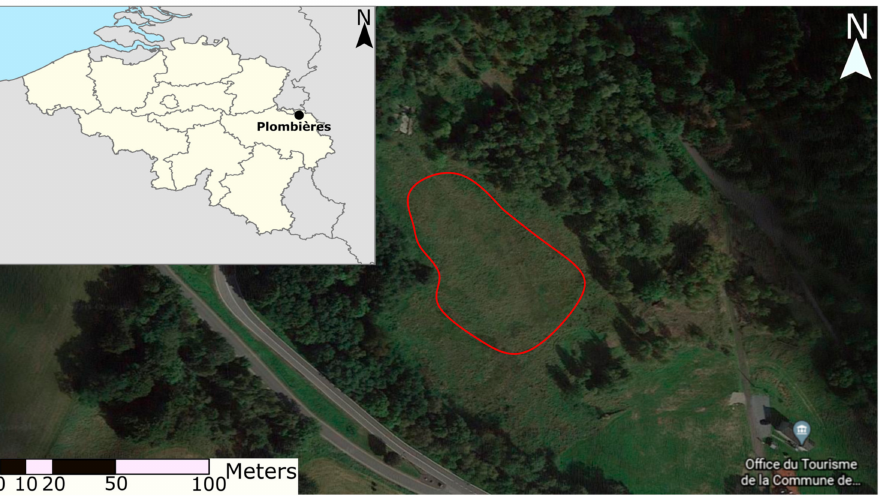
Figure 1. Map of the Plombi è res area showing the location of the tailings pond (Google Maps, 2019, maps.google.com). Red polygon represents the studied area of the tailings